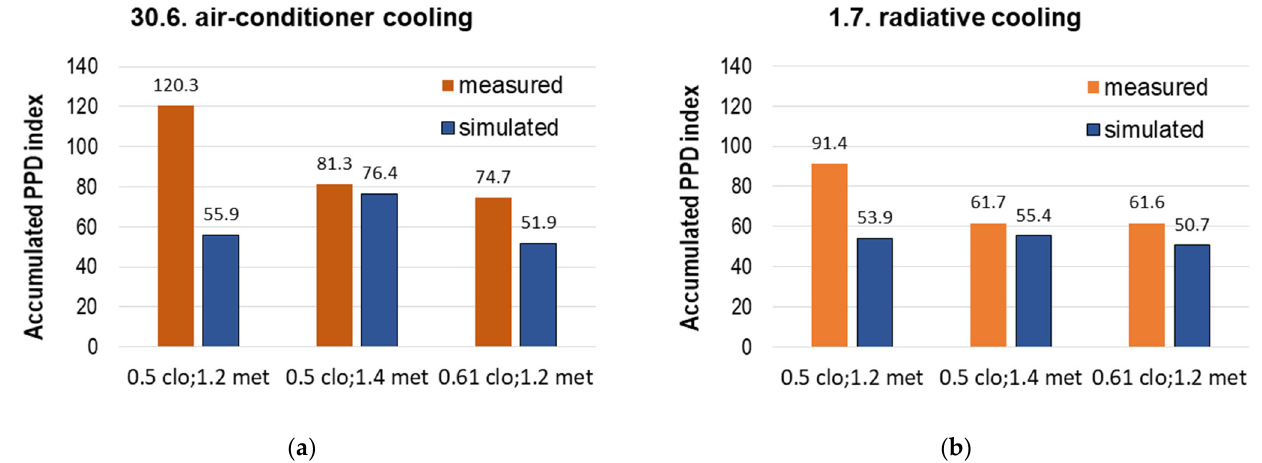
Figure 19. Comparison of cumulative PPD indices calculated from measured data and from simulated data : ( a ) for 30 June, ( b ) for 1 July.